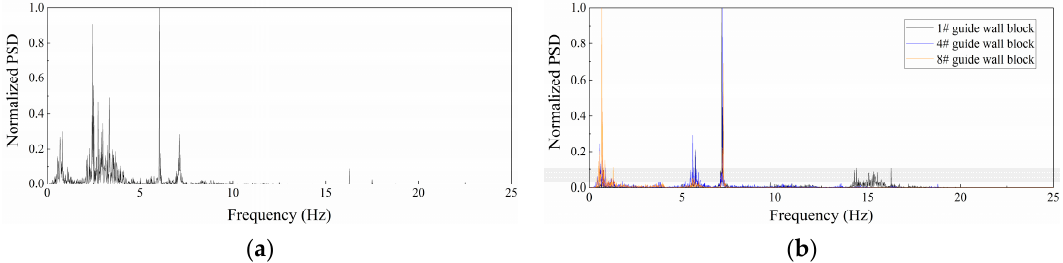
Figure 3. The comparison of Fourier Transform (FT) spectrums of horizontal displacements of the 1# dam block and typical guide wall blocks. ( a ) 1# dam block; ( b ) typical guide wall blocks.